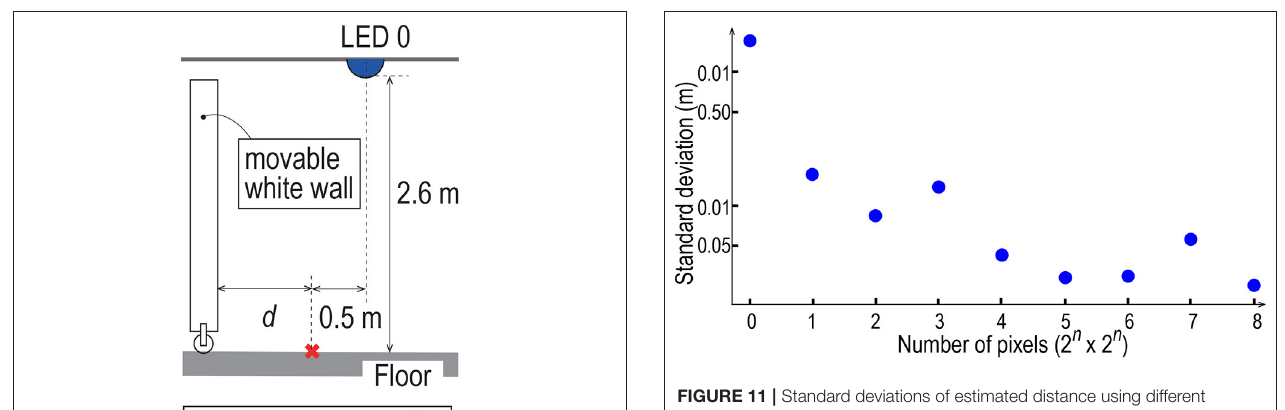
FIGURE 11 | Standard deviations of estimated distance using different numbers of pixels.